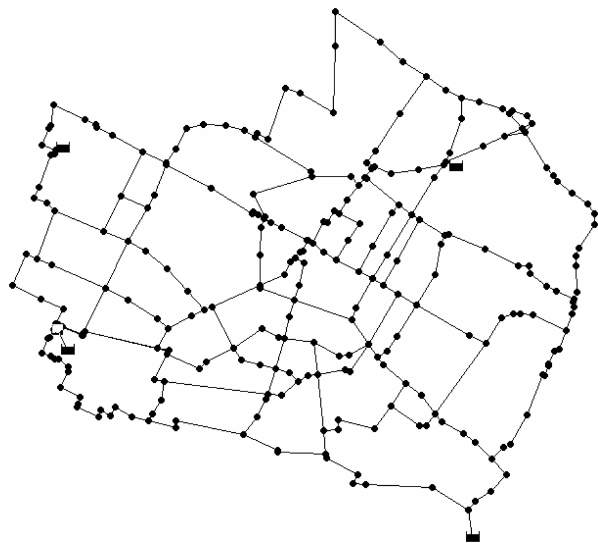
Figure 5. Layout of Modena network (example